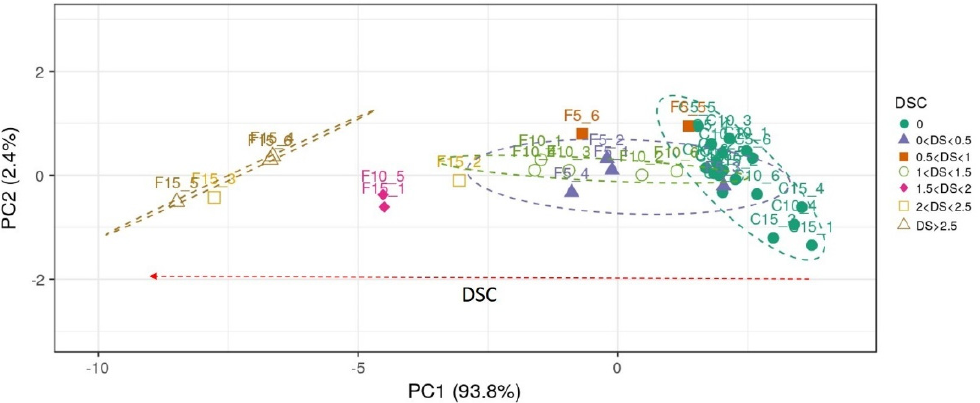
Figure 7. Principal component analysis biplot for infected (F, n = 18) and healthy control (C, n = 18) wild rocket pots examined at 5, 10, and 15 dpi (cases) for the 12 selected vegetation indices (variables). Unit variance scaling is applied to the rows; SVD with imputation is used to calculate principal components. X and Y axis show principal component 1 and principal component 2, explaining 93.8% and 2.4% of the total variance, respectively. Color grouping was performed by considering the disease severity classes (DSC) in the range 0 = healthy to 3 = highly infected. The prediction ellipses are such that with probability 0.95, a new observation from the same group will fall within the